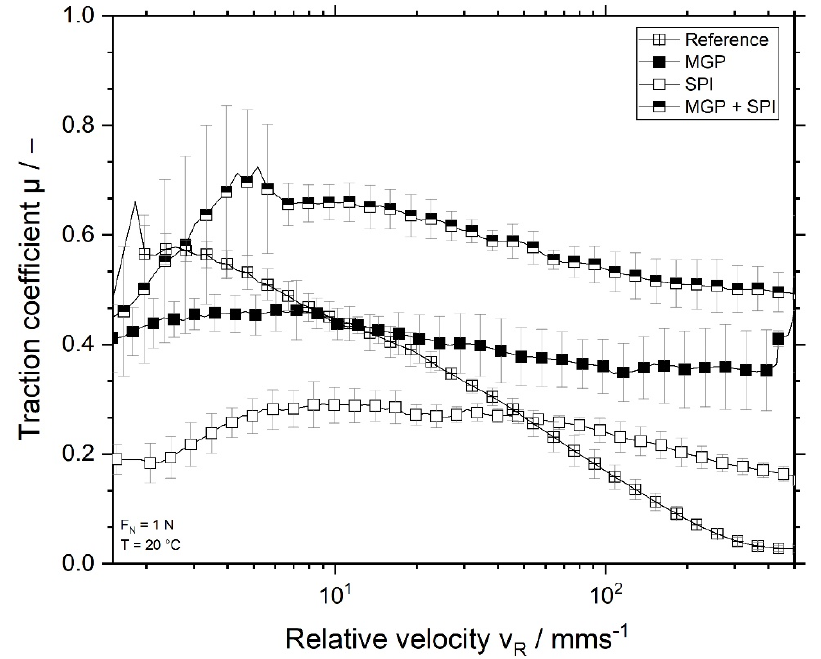
Figure 2. Amplitude test of fermented soy protein isolate (SPI) gels, measured at 20 °C, and an angular frequency of 1 rads − 1 . Reference sample, without oil and SPI emulsion gels (droplets stabilised with microgel particles (MGP) , with SPI , or both MGP + SPI ). Figure 7. Traction coefficient of fermented SPI gels over the relative (sliding) velocity, measured at 20 °C, using PDMS pins and a stainless steel ball as tribo-pairs. Reference sample, without oil and SPI-emulsion gels (droplets stabilised with MGP , with SPI , or both MGP + SPI ).